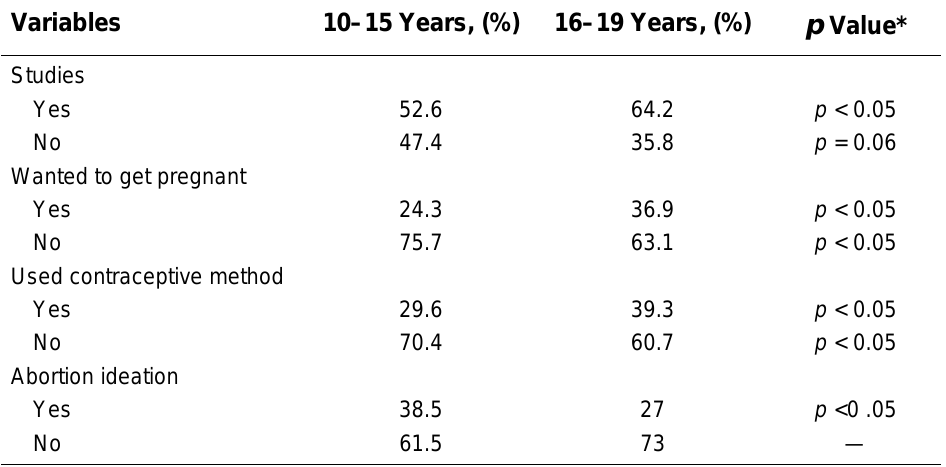
Trends of Some Variables in Connection with Schooling, Pregnancy, and Abortion Based on Age